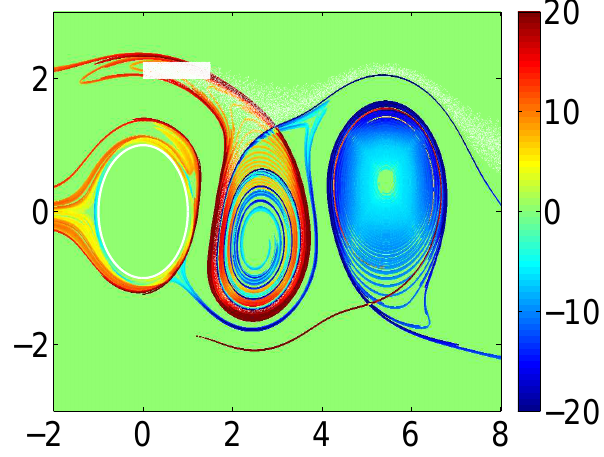
Fig. 8. Spatially averaged abundance of the phytoplankton groups in the region of vortices. P ext 1 : P 1 in the exterior of the vortices. P int 1 : P 1 in the interior of the vortex. P ext 2 : P 2 in the exterior of the vortices. Dashed-dotted line: P int 2 in the interior of the vortices.